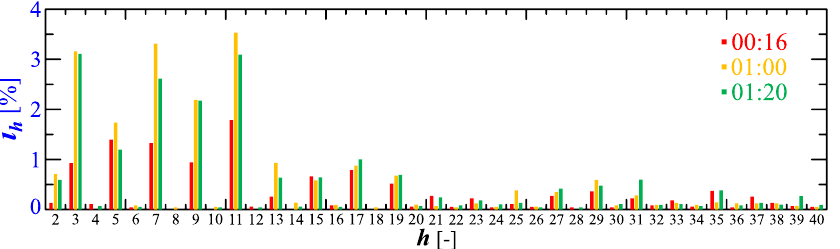
Figure 10. The amplitude spectrum of the current i h = f ( h ) recorded at 00:16, 1:00, and 1:20 for Case I.